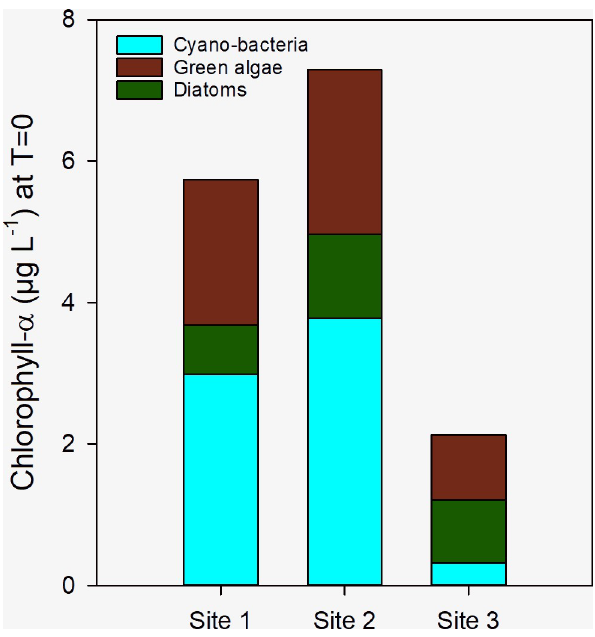
Fig 2. Initial chlorophyll-a concentrations ( μ g L -1 ) at t = 0 of Lake Lesser Prespa. Blue = cyanobacteria, Green = green algae, Brown = Diatoms, as measured at sites